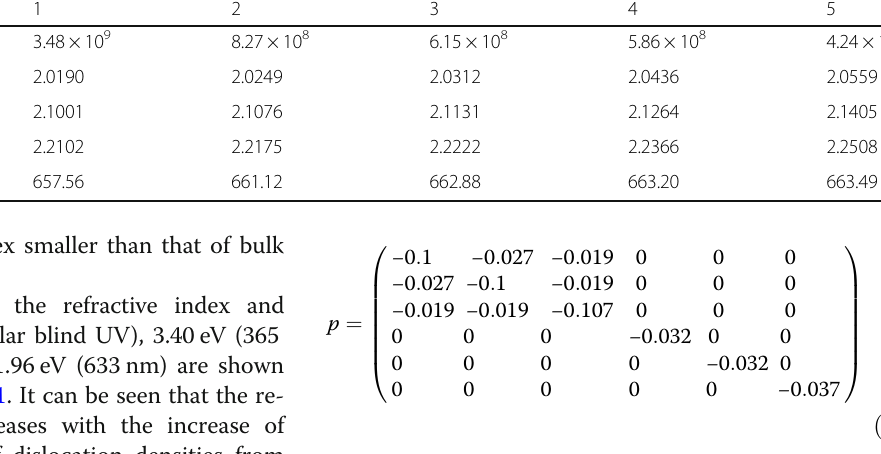
The strain field matrices of screw dislocation and edge models of the two kinds of dislocation are described in Fig. 3. According to the models, the distribution of the strain field around single dislocation can be obtained [31, 32].